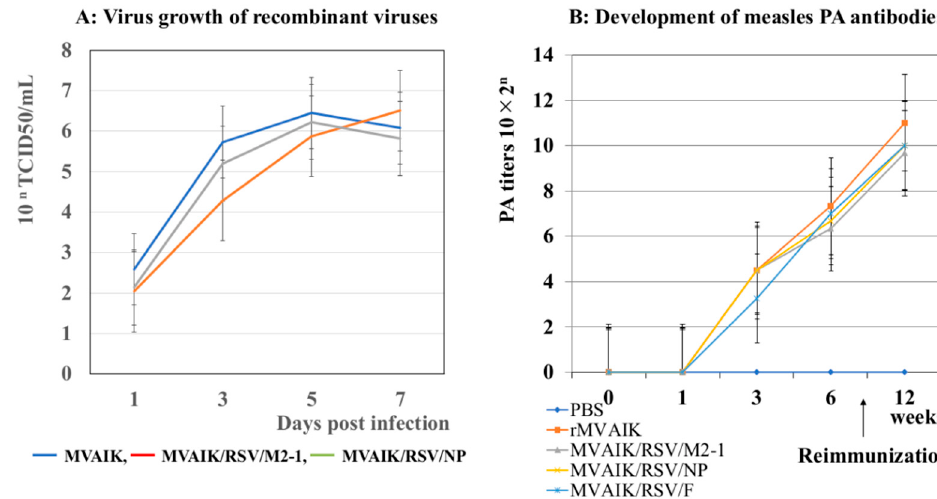
Figure 2. Virus growth and the development of PA antibodies. ( A ) Virus growth of the recombinant MVAIK, MVAIK/RSV/NP, and MVAIK/RSV/M2-1. Culture fluids were obtained on Days 1, 3, 5, and 7 of the culture and infectivity was shown as 10 n TCID50 in Vero cells. ( B ) Development of PA antibodies. Cotton rats were immunized with MVAIK, MVAIK/RSV/F, MVAIK/RSV/NP, and MVAIK/RSV/M2-1, and re-immunized at 8 weeks after the first dose. Blood samples were obtained serially, and PA antibody was examined. Figure 2B was reported in reference No.